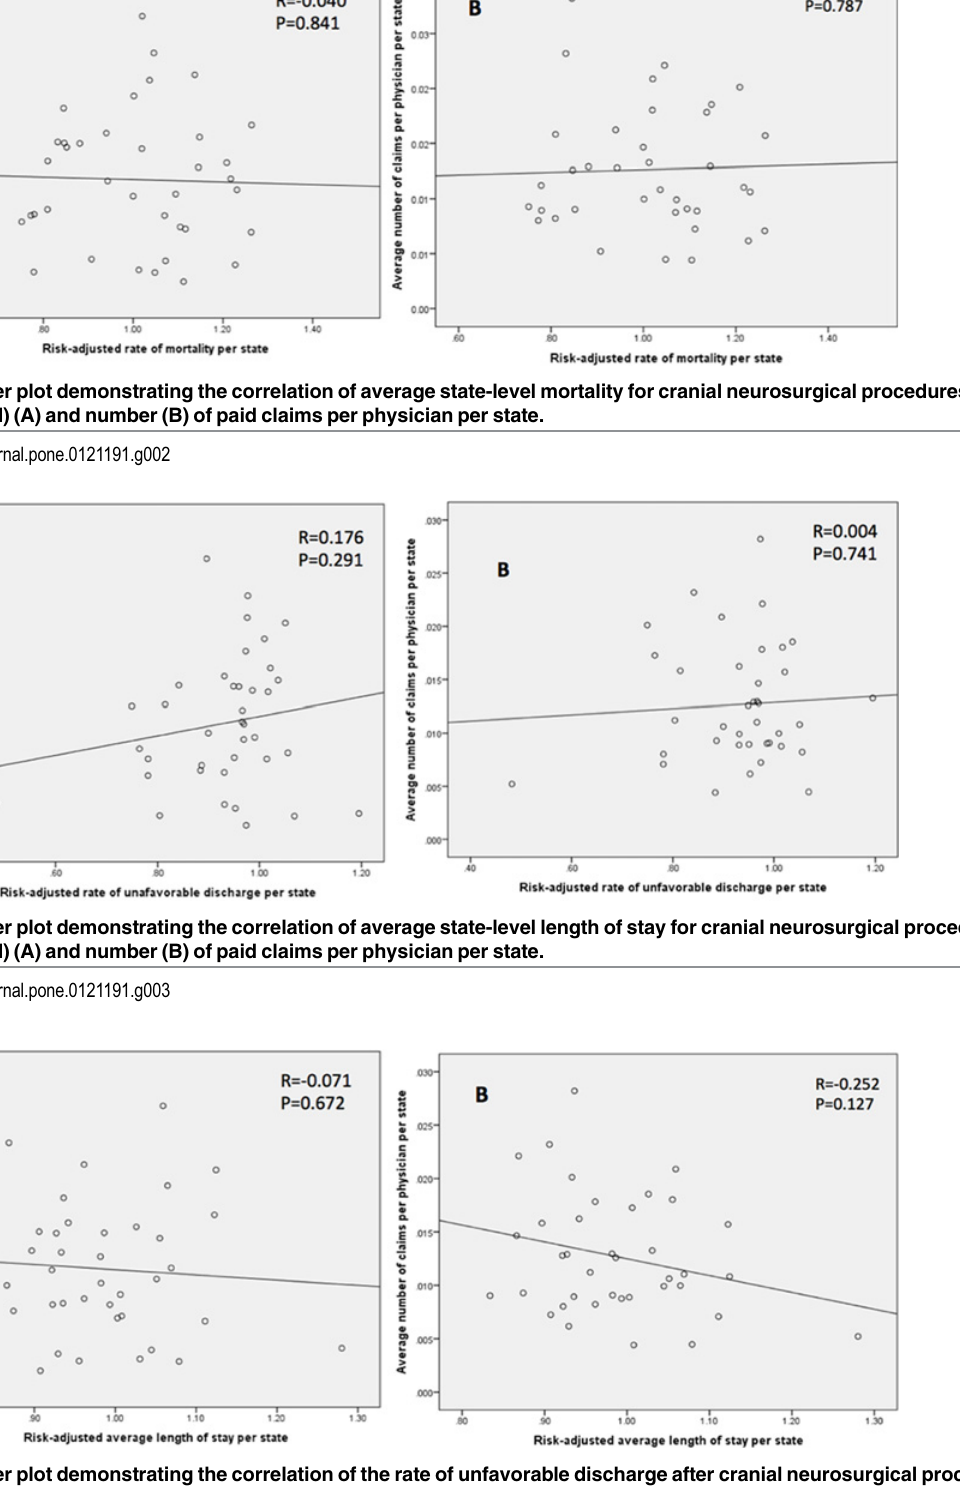
PLOS ONE | DOI:10.1371/journal.pone.0121191 March 23,